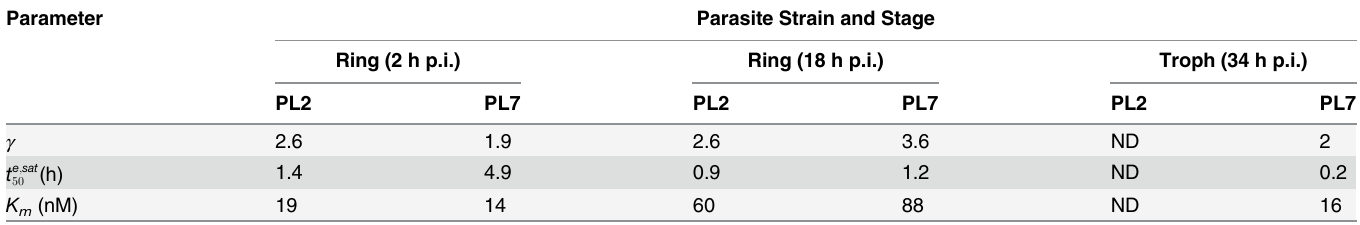
Table 1. CED model parameters for PL2 and PL7